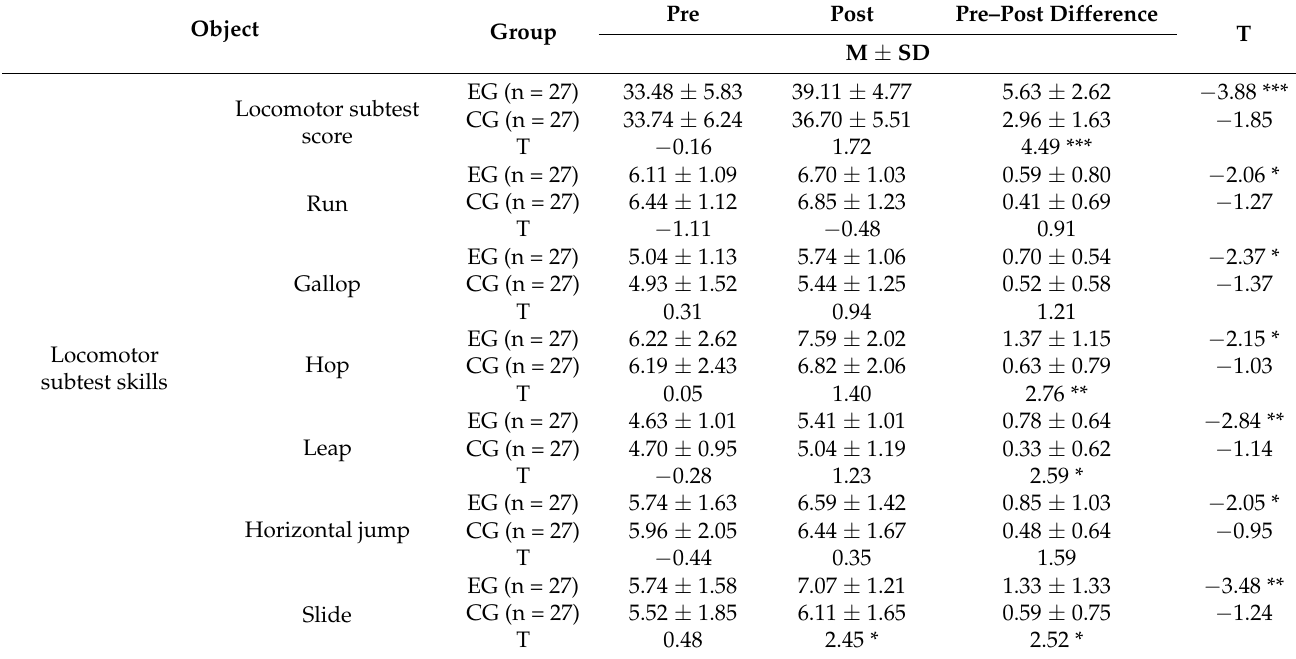
Table 8. Comparison of locomotor subtest skills and object control subtest skills between female EG and CG pre- and post-intervention. Object